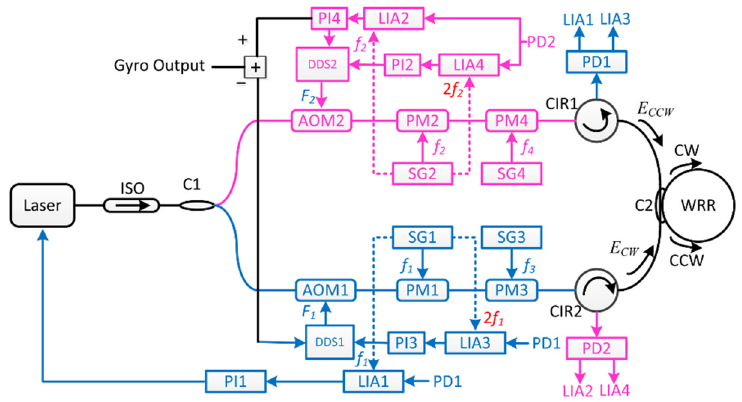
Figure 12. Schematic diagram of the RIOG with the light intensity feedback loop. Reprinted with permission from ref. [35]. Copyright 2014 The Optical